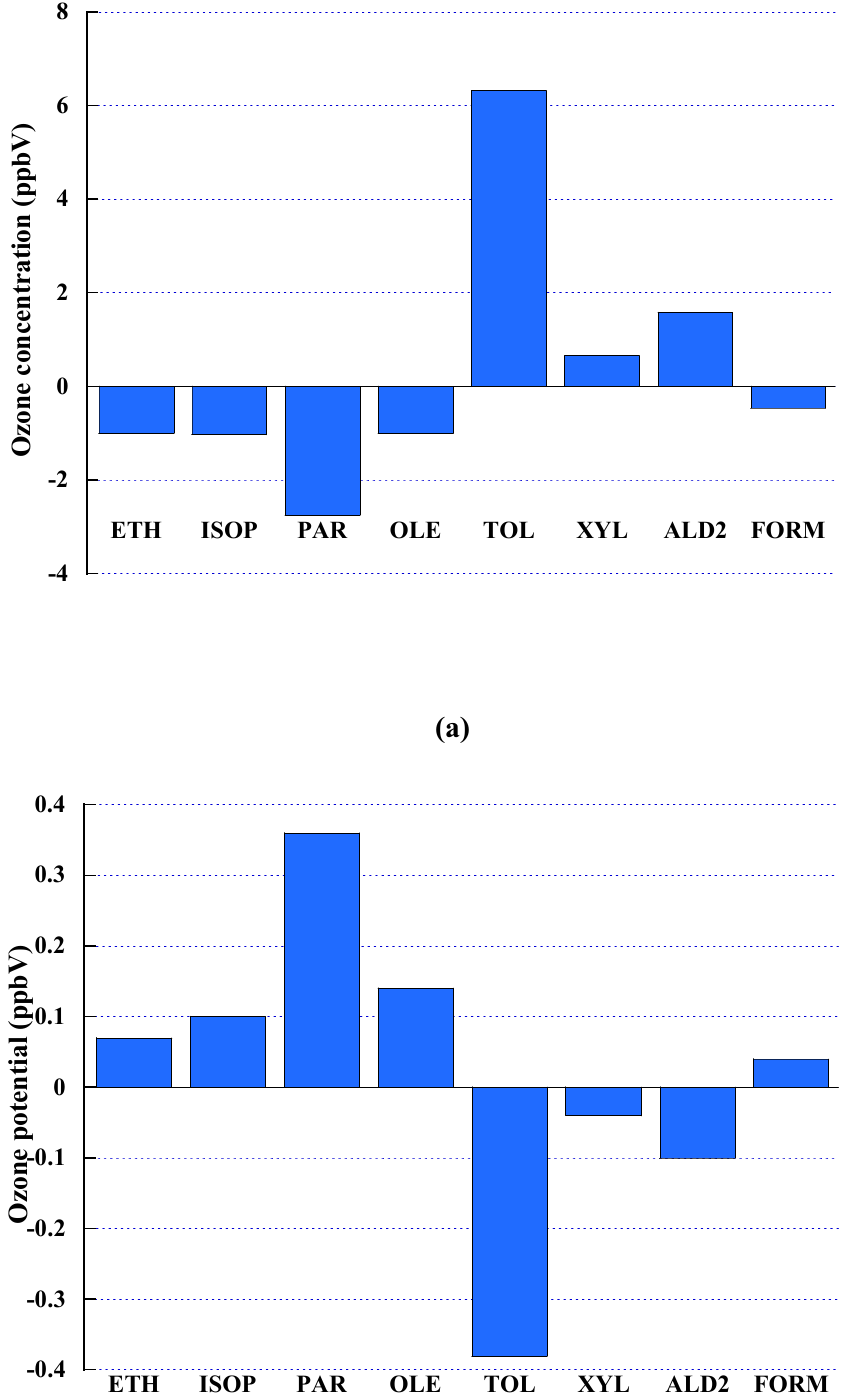
Figure 6. (a) The change in the peak ozone (ppbV) at downtown El Paso after reducing the mixing ratio of each VOC subspecies by a factor of 50%; one subspecies at a time; (b) the ozone potential (ppbV) of the individual VOC